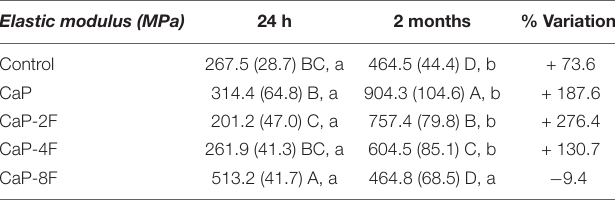
TABLE 3 | Means (standard deviations) of elastic modulus